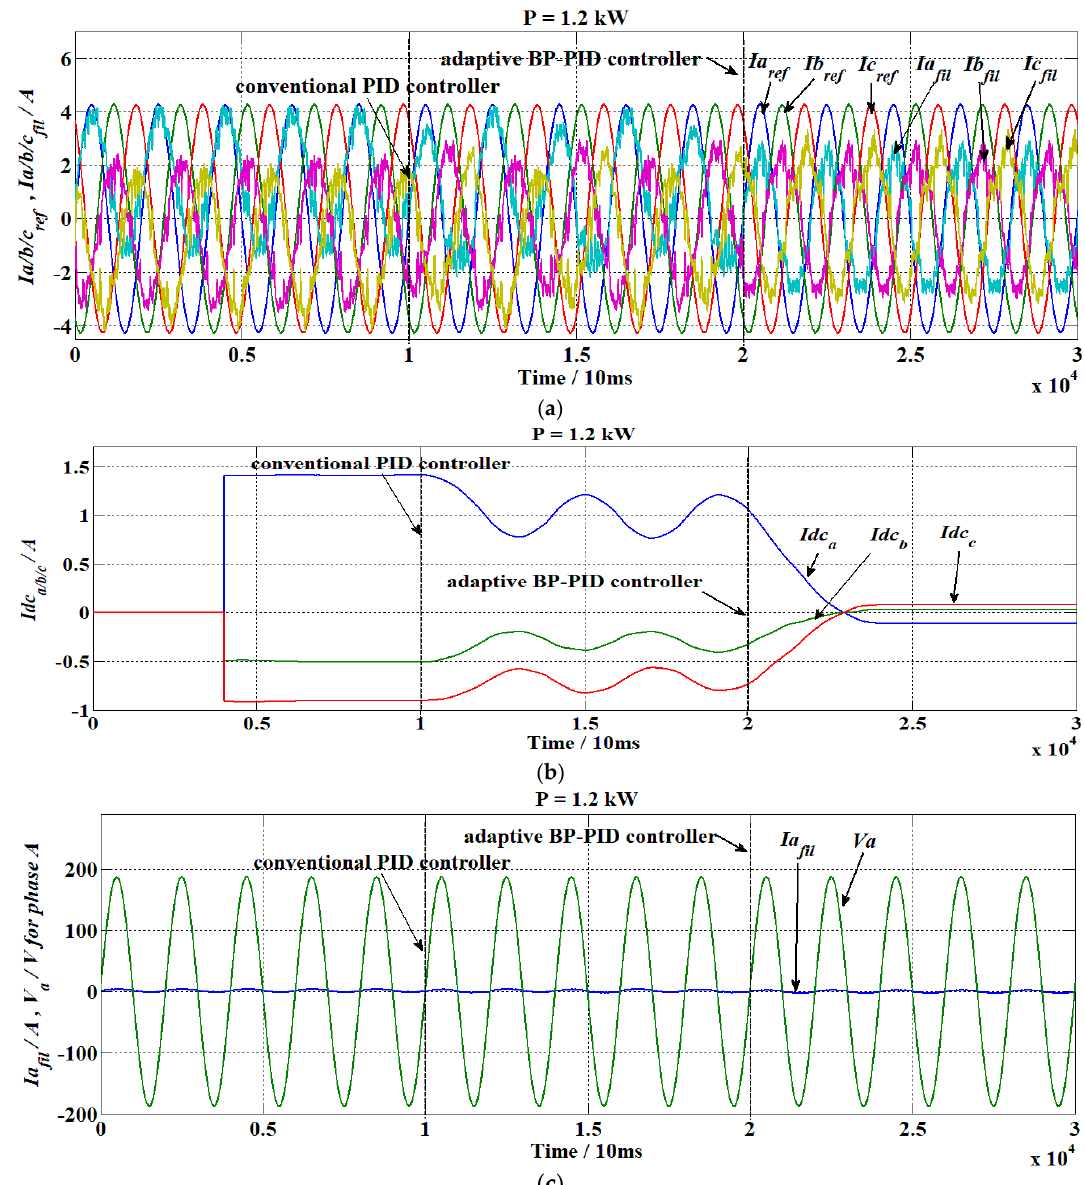
Figure 6. Waveforms of dc component, grid voltage and current using PID controller and adaptive BP-PID controller for dc-component suppression in three-phase system, respectively ( P = 1.2 kW, Q = 0), respectively. ( a ) reference and feedback currents. ( b ) dc component extraction using SWDIM. ( c ) current and voltage output of phase-A.